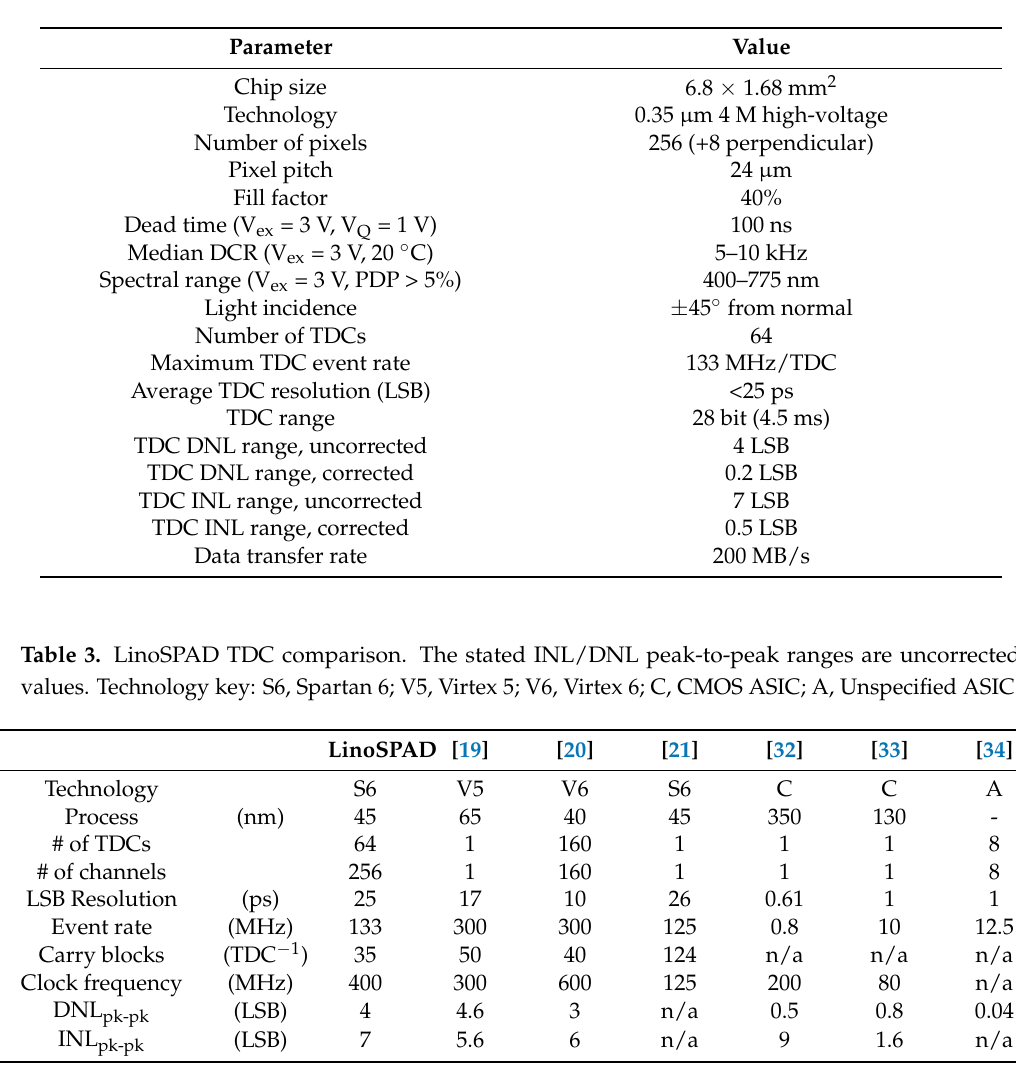
Table 2. LinoSPAD performance summary.